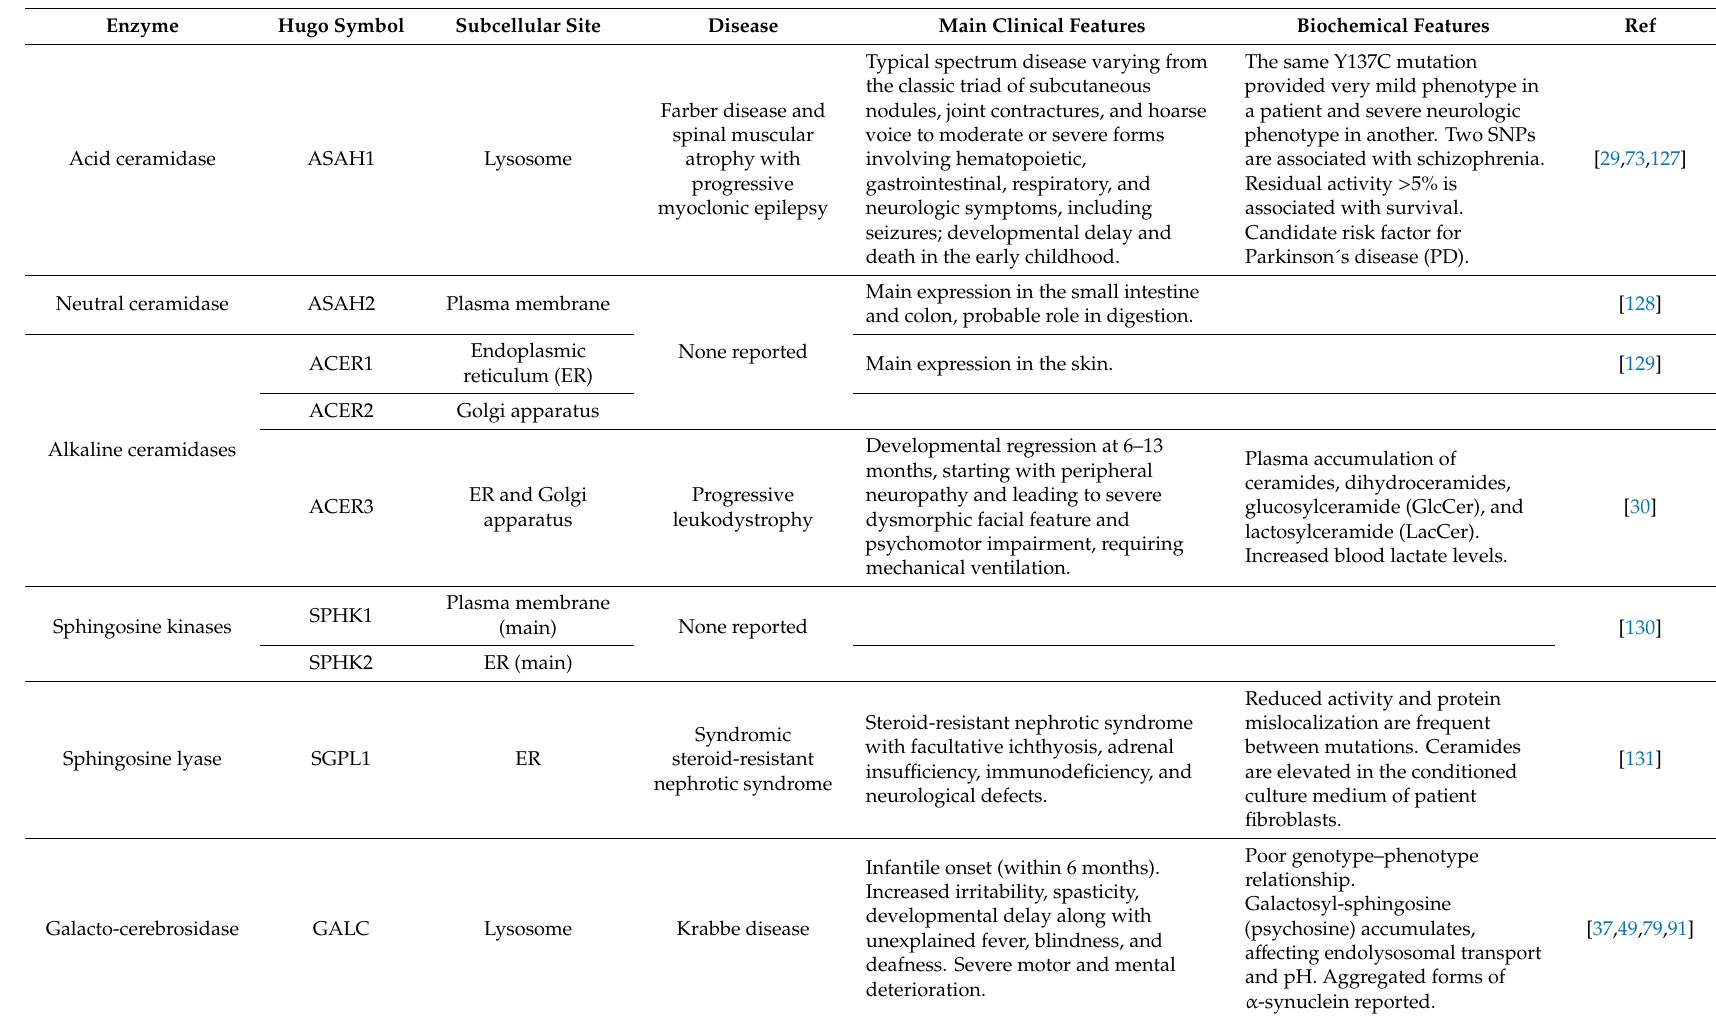
Table 1. Enzymes involved in sphingolipid degradation and